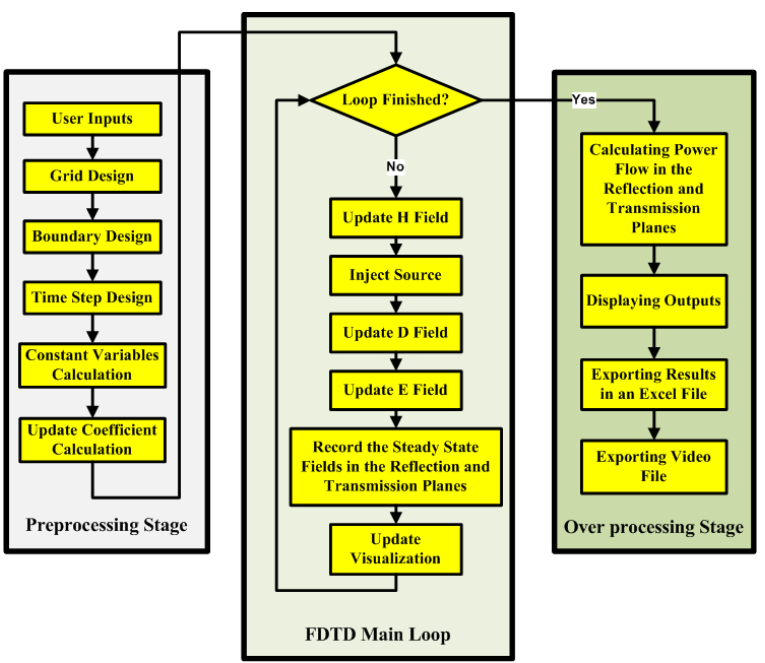
Figure 1. Practical block diagram used for implementing both FDTD and OFDTD algorithm.